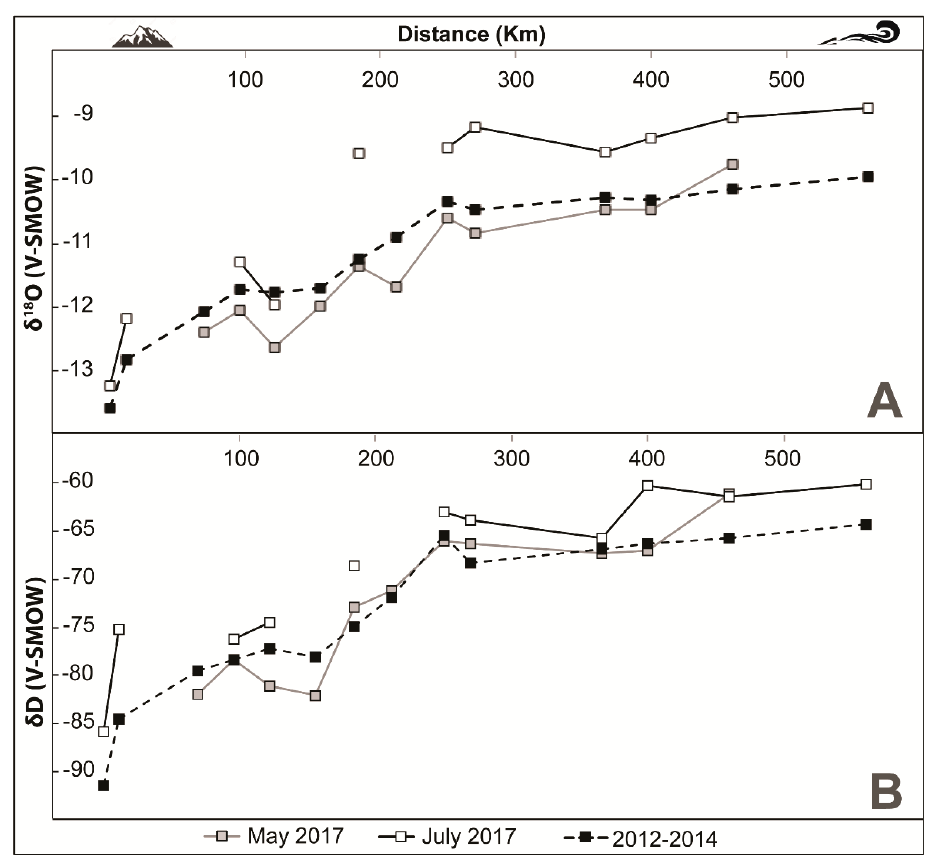
Figure 2. Variation of the δ 18 O ( A ) and δ D ( B ) of Po river water (Table 1 and Supplementary Table S1 in the Supplementary Materials) at varying distances from the source, down to the closure section of Pontelagoscuro.